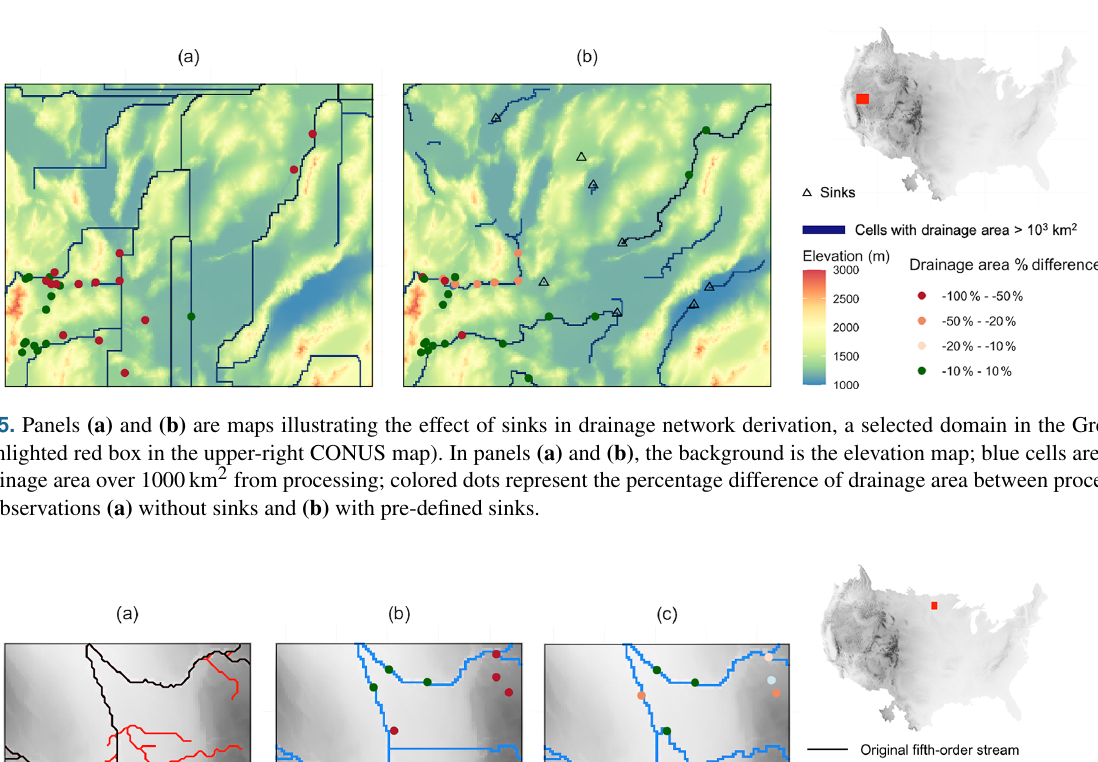
prove performance for gages less than 100 km 2 . Area